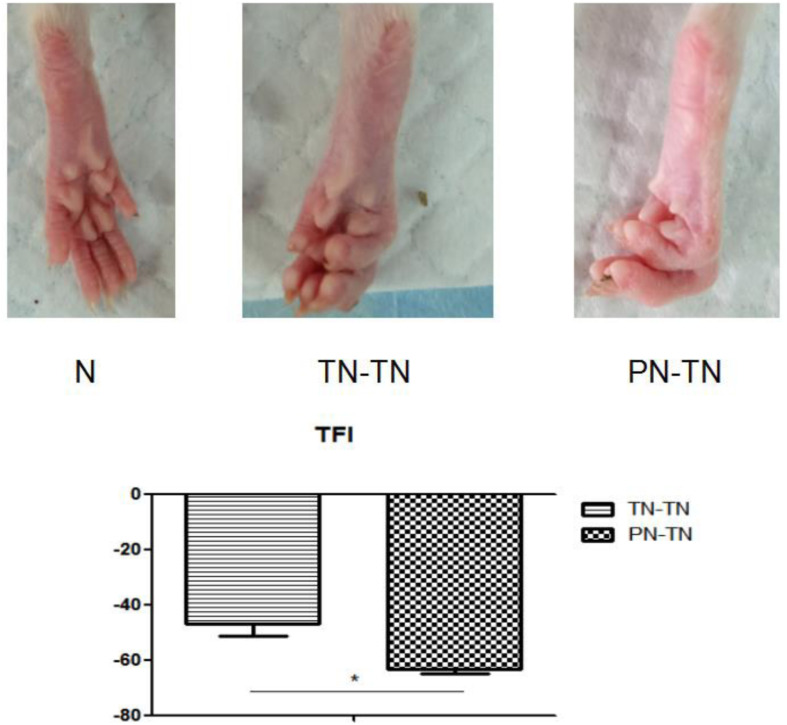
The first row shows the morphology of the right hind paw of a rat from each of the three groups. It can be seen that the toes of the rat in the N group were naturally separated with full plantar muscles. In the TN-TN group, the five-toed curling deformity was mild, and the plantar muscles were slightly atrophied. The five-toe curling deformity was obvious, and the plantar muscles were obviously atrophied in the PN-TN group. The second row shows the TFIs of PT-TN and TN-TN group. *P < 0.05.